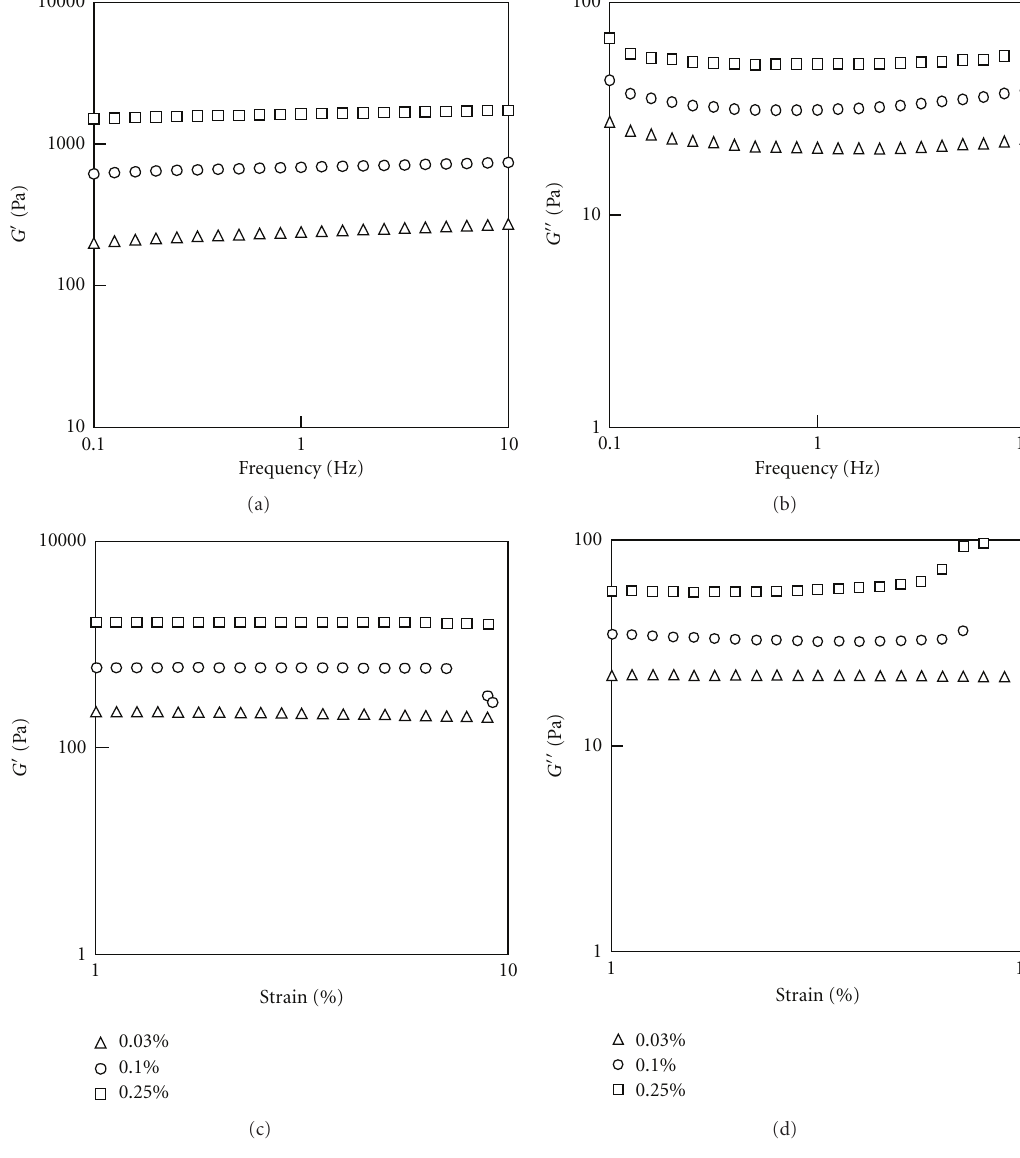
Figure 5: (a, b) Dynamic storage and loss moduli from frequency sweep rheological tests; (c, d) from strain sweep rheological tests of collagen sca ff olds crosslinked with 0.03%, 0.1%, and 0.25%